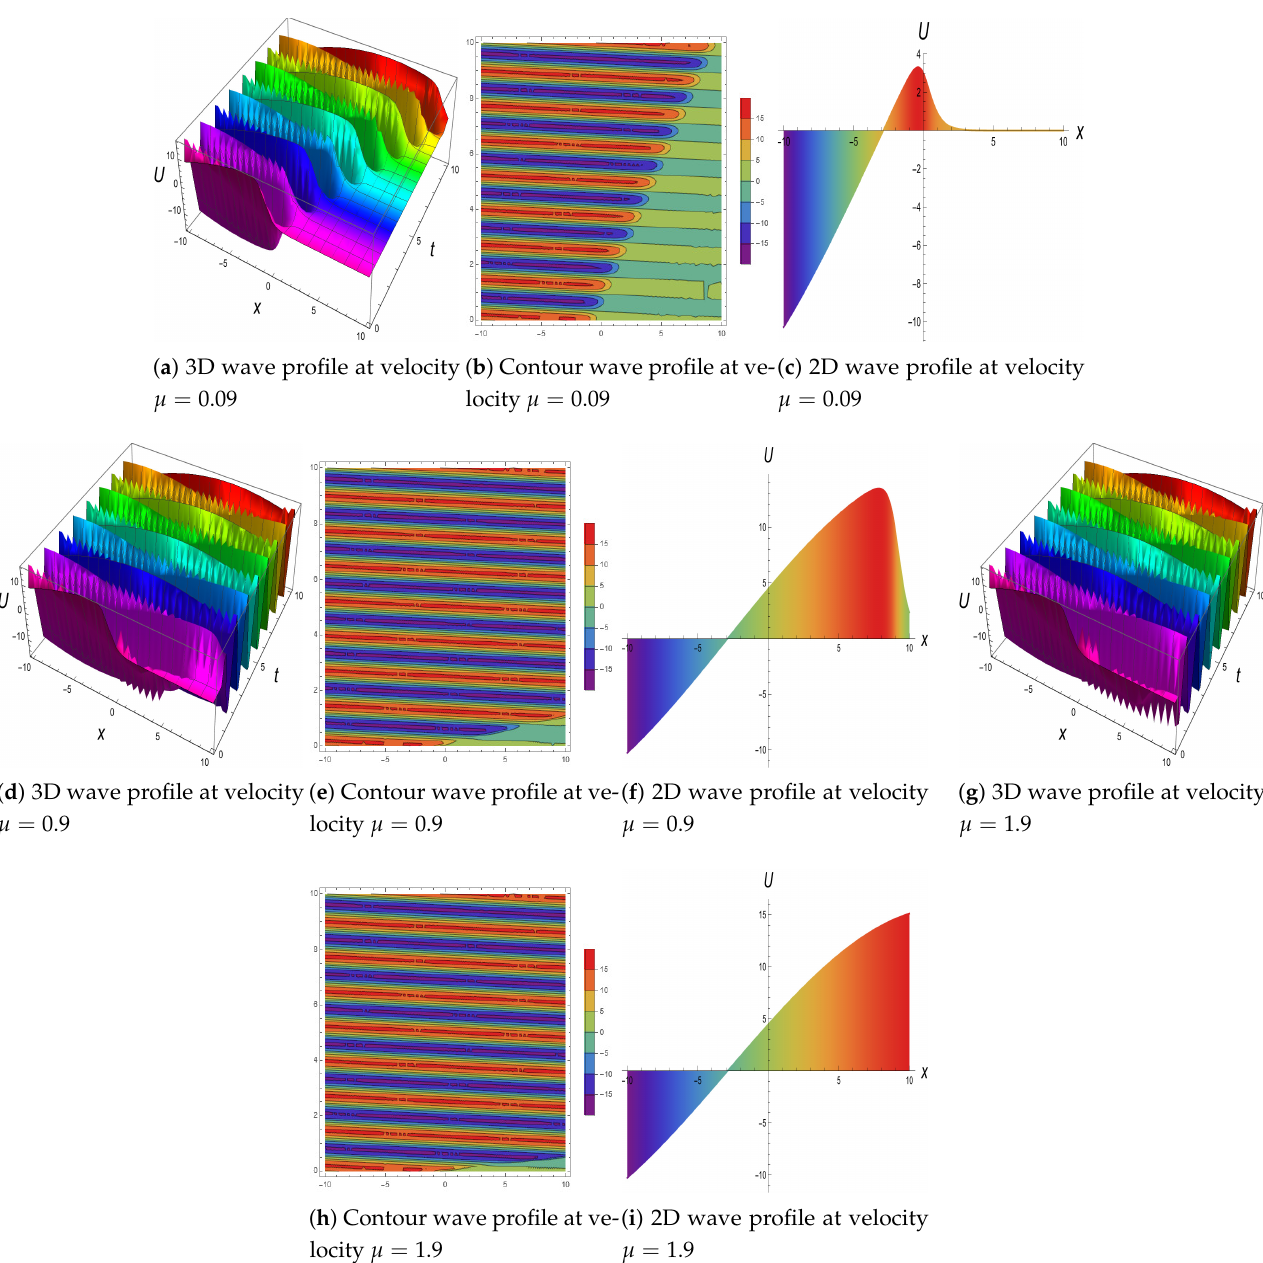
Figure 5. For the real part of solution Equation (98), the impact of velocity is seen in 3D, 2D, and